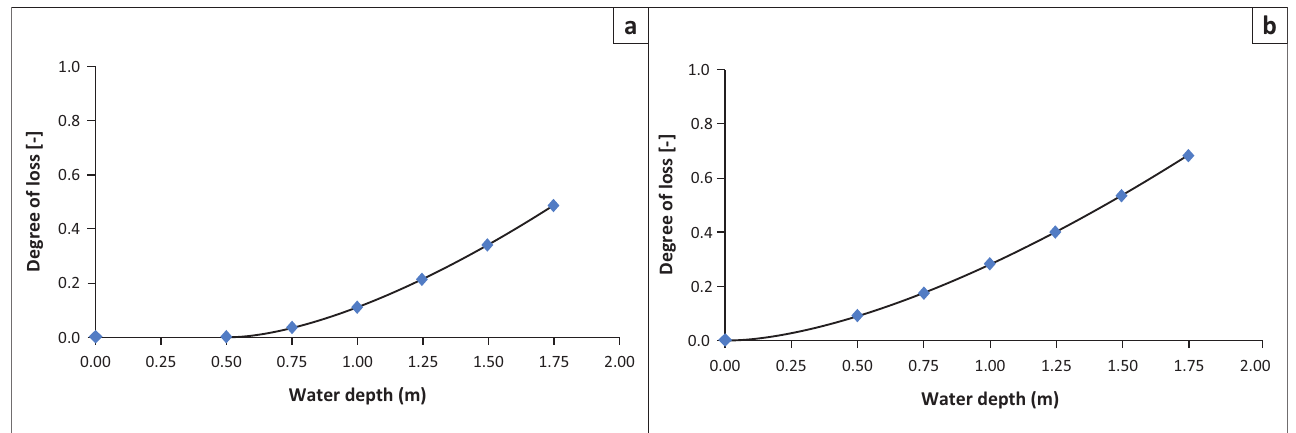
FIGURE 4: Results for the two different models. (a) The order-2 polynomial model (M